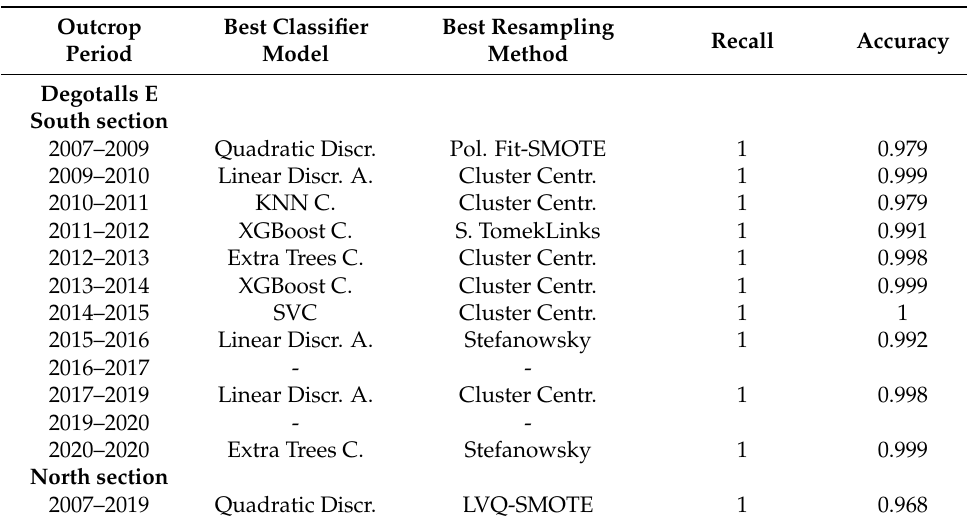
Table 9. Summary of the metric for the predictive models results with Recall and Accuracy parameters. Degotalls N presents two solutions: a the best solution with False Negatives = 0 or b the best solution, but accepting a reduced number of False